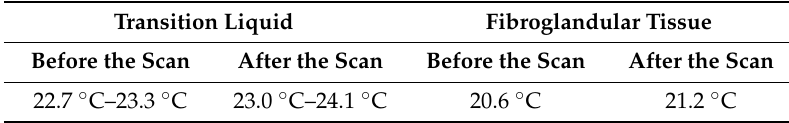
Table 2. Temperature Measurement Conditions: Breast Phantom Validation